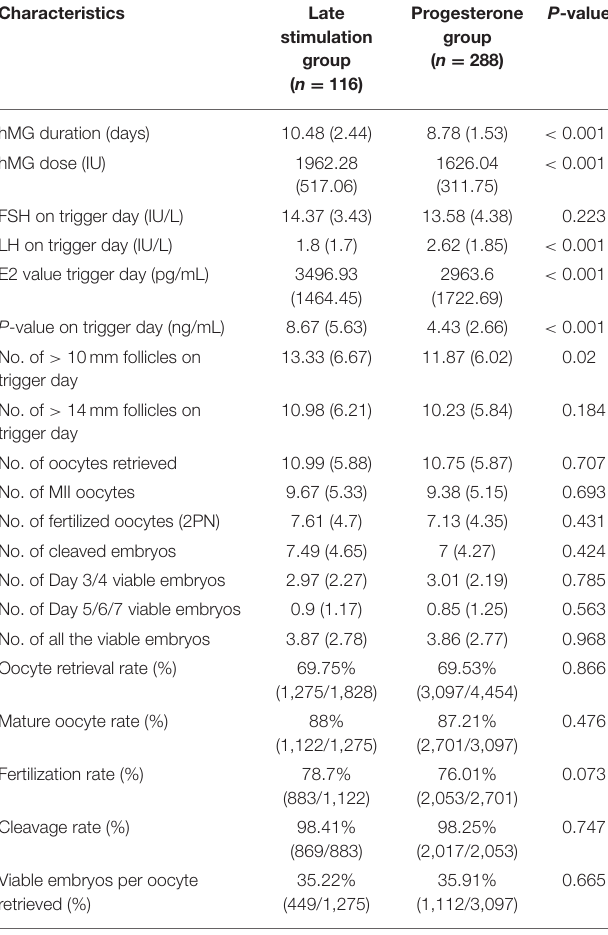
TABLE 3 | Pregnancy and live-birth outcomes of frozen-thawed embryos derived from the two regimens.